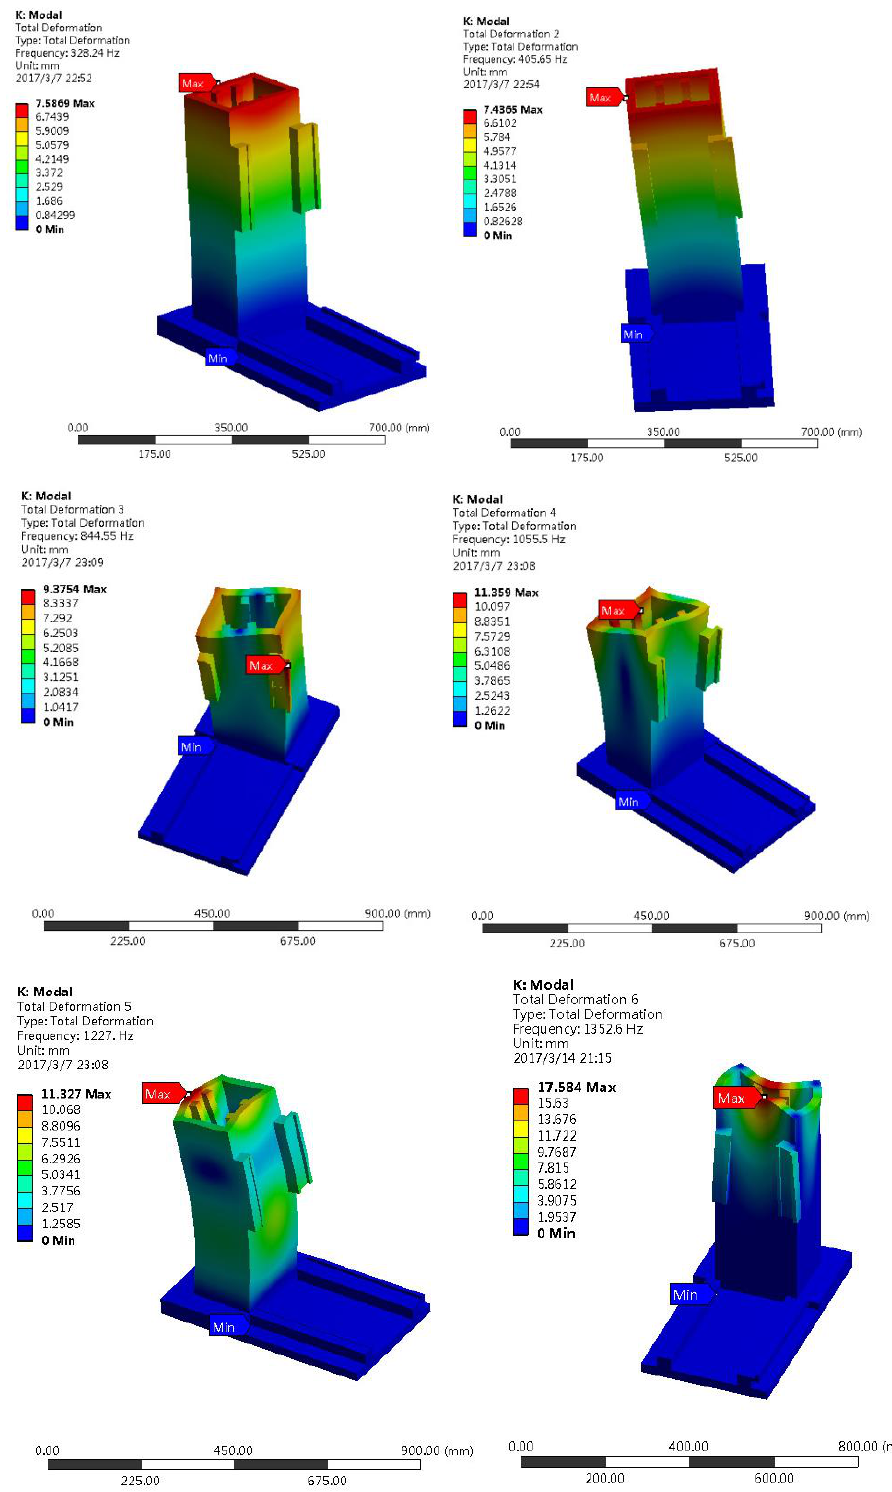
Figure 13. Diagram of the first six-order mode of the integral